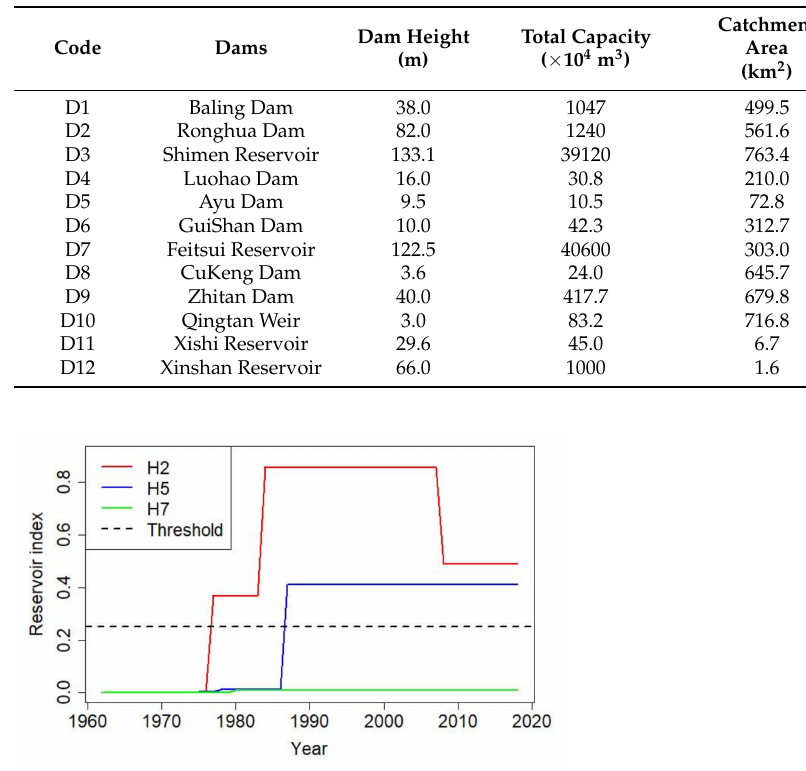
Table 5. Basic information on dams in Tamsui River basin, Taiwan.